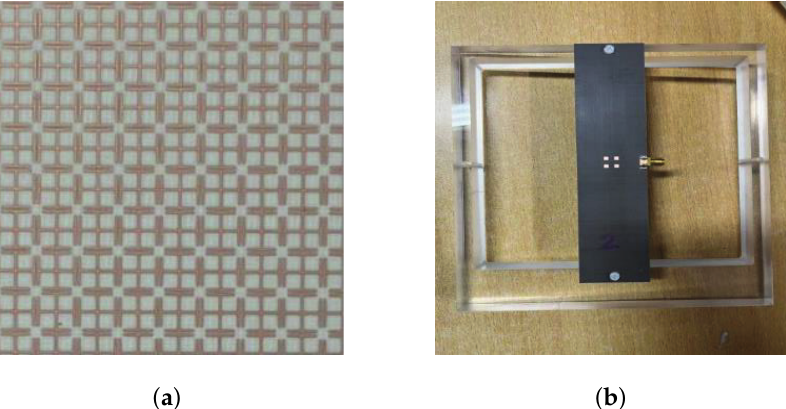
Figure 8. Photographs of the fabricated prototype of the proposed metasurface lens and 2 × 2 patch-antenna array: ( a ) metasurface lens and ( b ) 2 × 2 patch-antenna